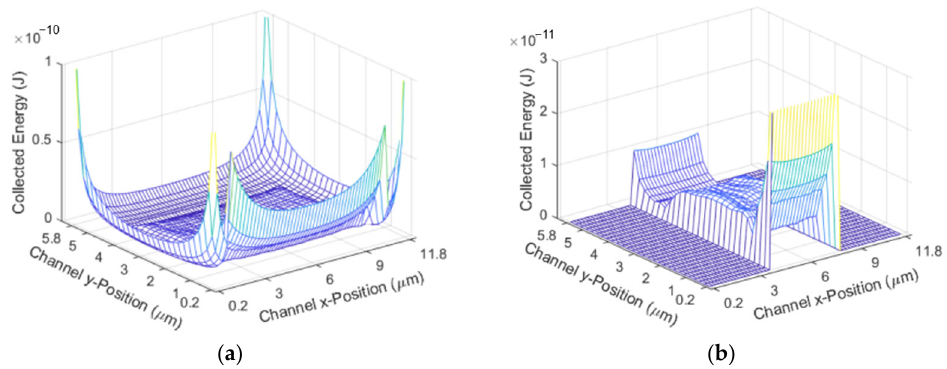
Figure 5. Excitation Region for: ( a ) The unfocused case; ( b ) the 2D focused